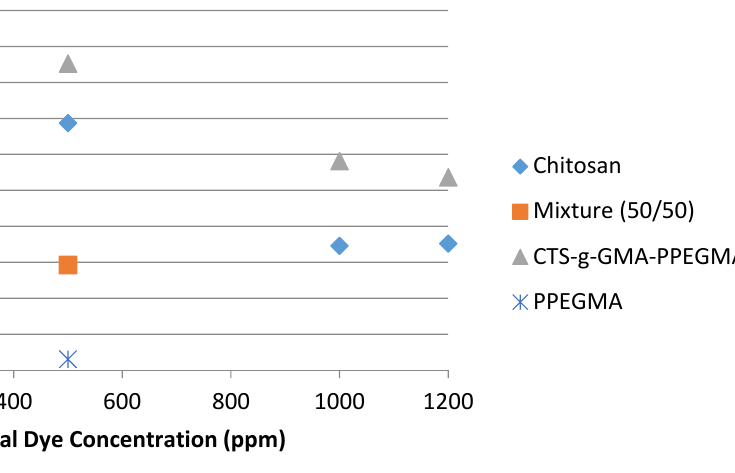
Figure 12. Adsorption % at different initial dye concentrations.